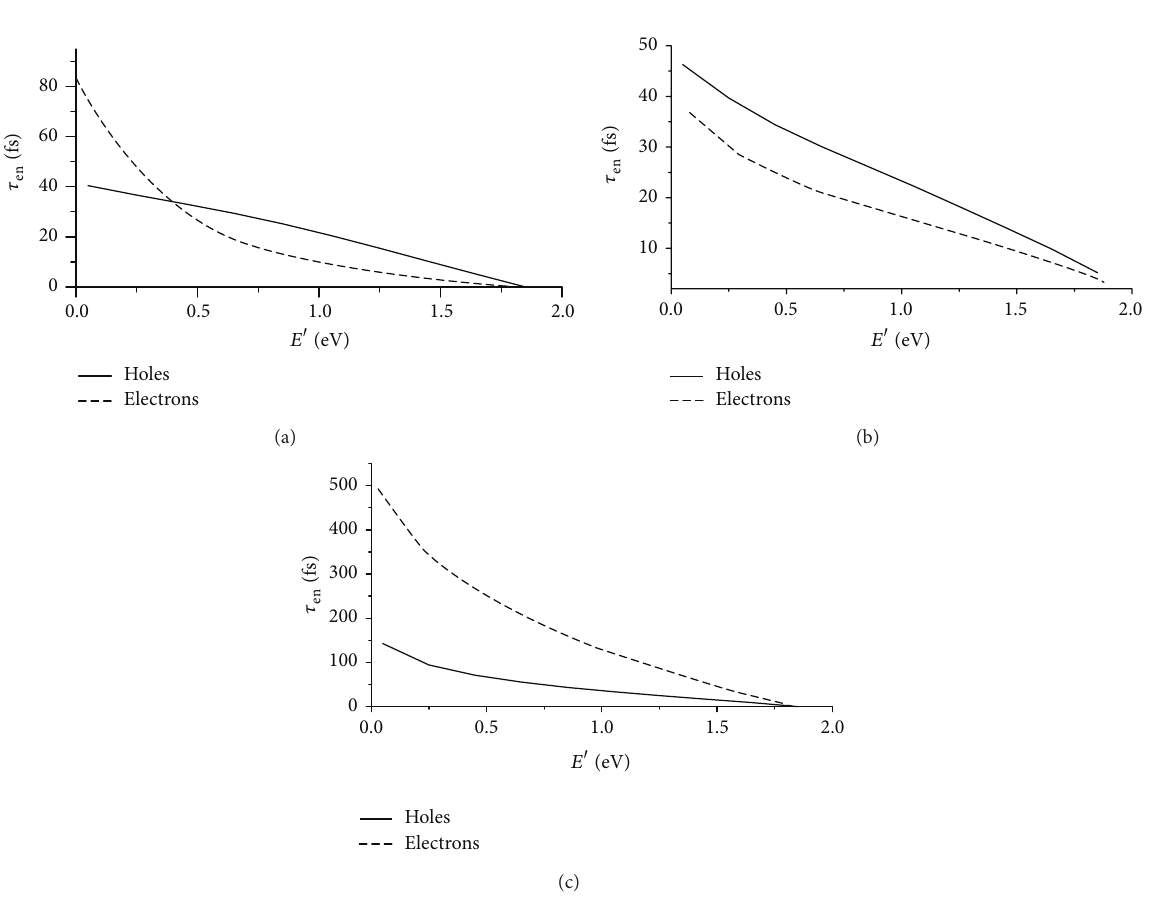
Figure 5: The time of energy loss of a hole (solid lines) depending on the final value of the excess energy 𝐸 󸀠 for anatase (a), rutile (b), and zinc oxide (c). It is assumed that in the initial moment the hole was excited to the level 𝐸 = 2 eV. For comparison, the analogous data are shown (dashed lines) for the energy loss time of excited electrons as calculated based on the results of the works [12,